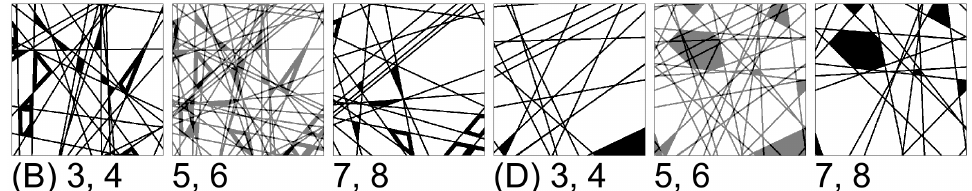
Figure 5. Image compression of two examples of consecutive images. Six BW images were com- pressed into three gray level images; ( B ) images 3–8 of a stack with b r = 18 µm; ( D ) images 3–8 of a stack with b r = ∞ ; see Figure